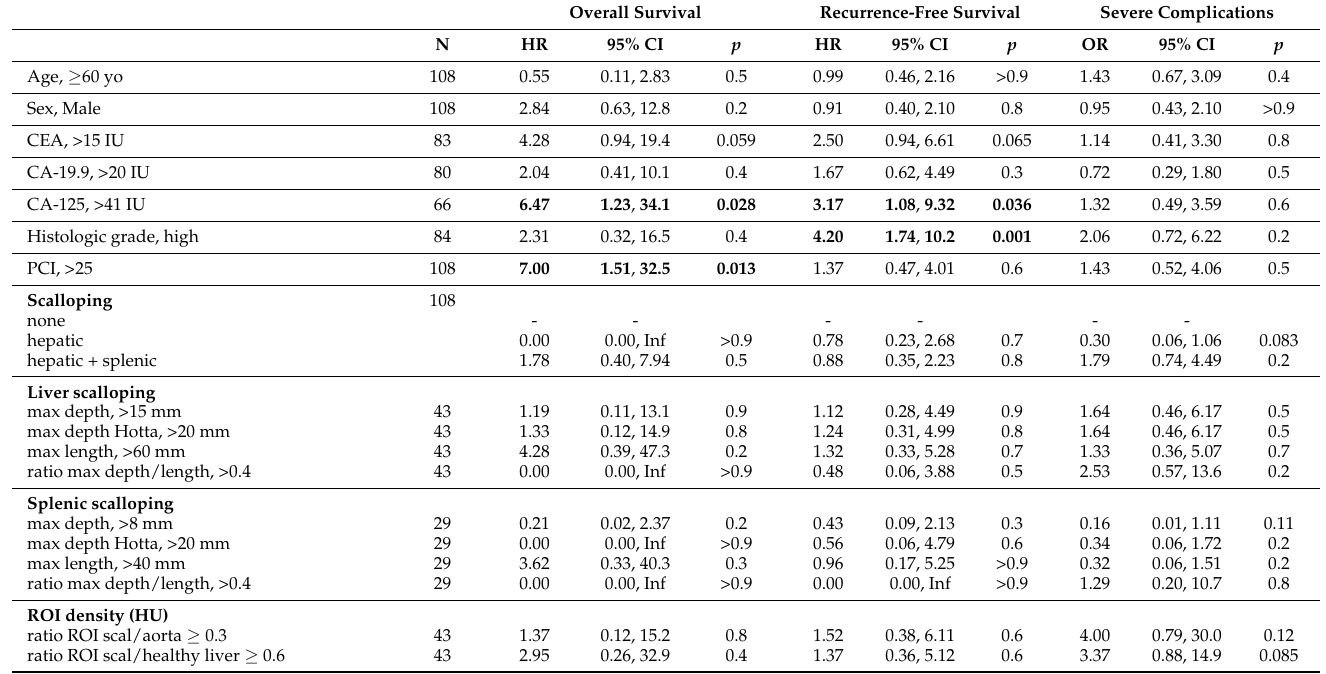
Table 4. Univariate analysis of predicting factors of overall and recurrence-free survivals and severe postoperative complications in completely resected patients. Overall Survival Recurrence-Free